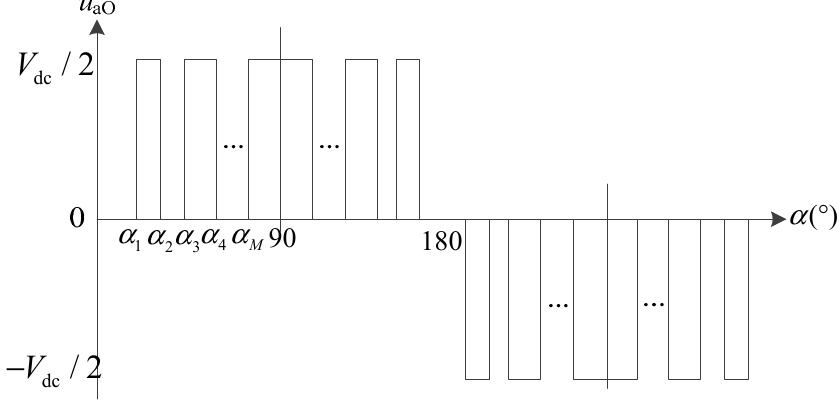
Figure 3. a-phase voltage u aO based on the unipolar SHEPWM.